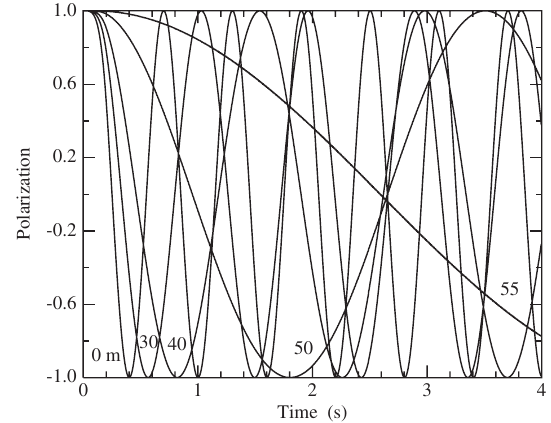
FIG. 13. Sample curves of the change in the vertical polariza- tion as a function of time for different synchrotron amplitudes A . All model calculations were made on resonance. As the syn- chrotron amplitude gets larger, the oscillation period increases. The curves represent values of A ¼ 0 ; 30 ; 40 ; 50 , and 55